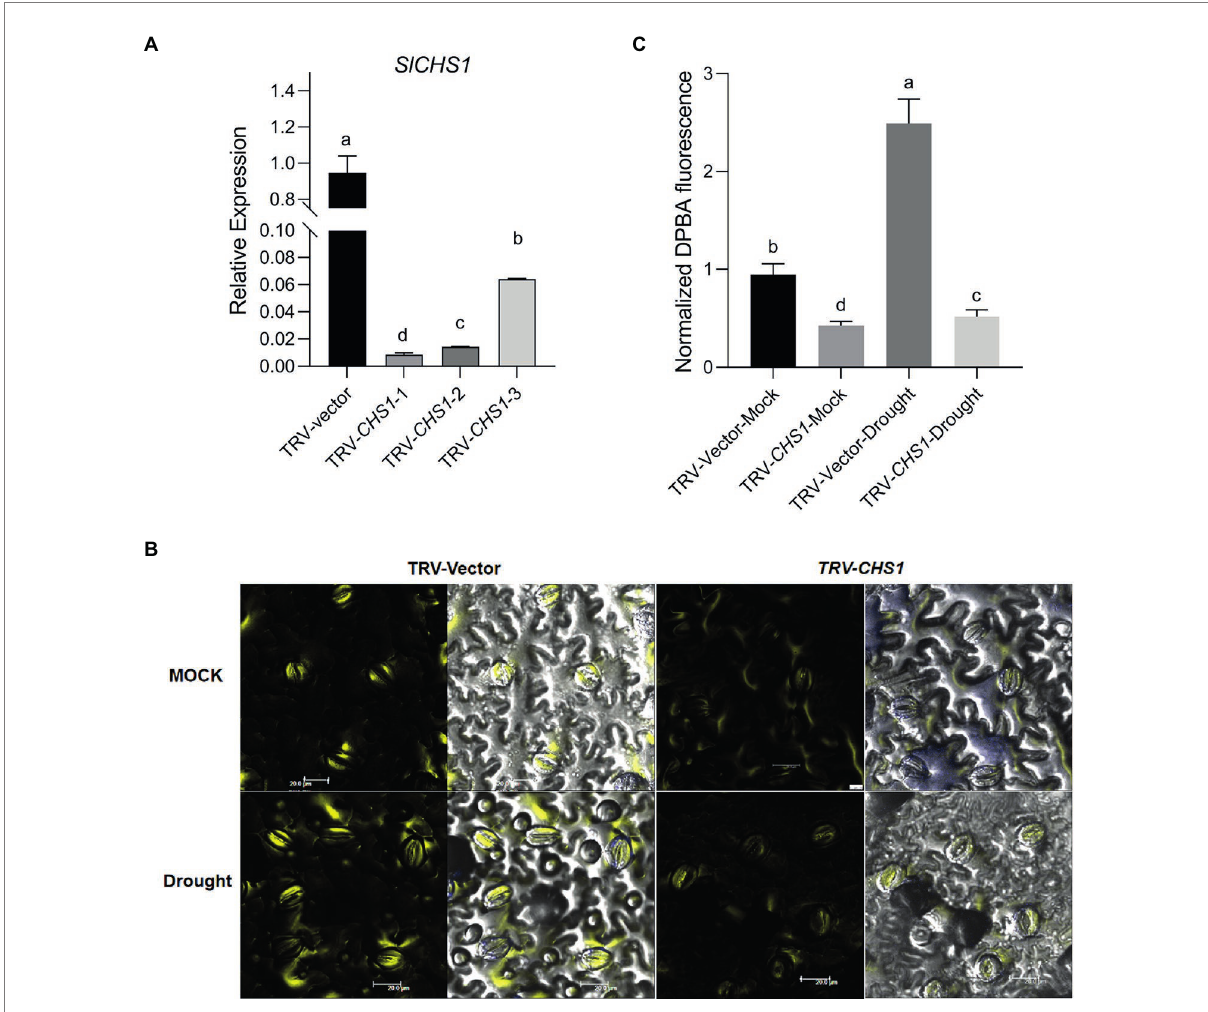
FIGURE 7 SlCHS1 -silenced plants exhibited a lower flavonol content in guard cells. (A) The expression of SlCHS1 in leaves of TRV-Vector and TRV- CHS1 tomato plants. (B) Confocal micrographs of DPBA-stained guard cells of TRV-Vector and TRV- CHS1 plants. DPBA fluorescence is shown in yellow (bar = 20 μ m). (C) Quantification of DPBA fluorescence in guard cells of TRV-Vector and TRV- CHS1 plants subjected to 8-day water loss and mock treatments (TRV-vector-MOCK: n = 491; TRV- CHS1 -MOCK: n = 510; TRV-vector-Drought: n = 494; TRV- CHS1 -Drought: n = 505). Data were obtained from three experiments. Different letters represent significant differences ( p < 0.0001) determined using Tukey’s multiple comparisons